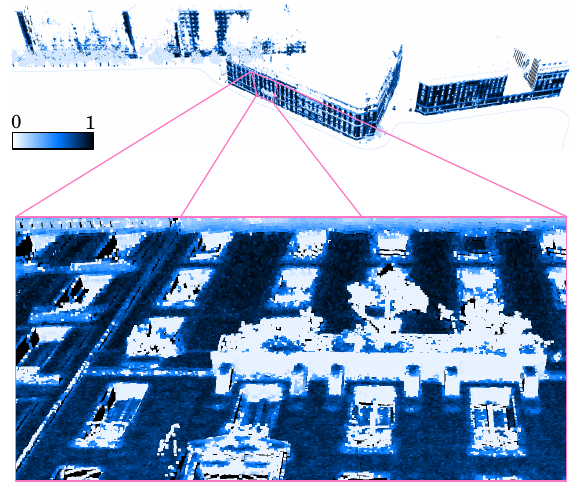
Figure 7: Probabilities that each 3D point belongs to a flat